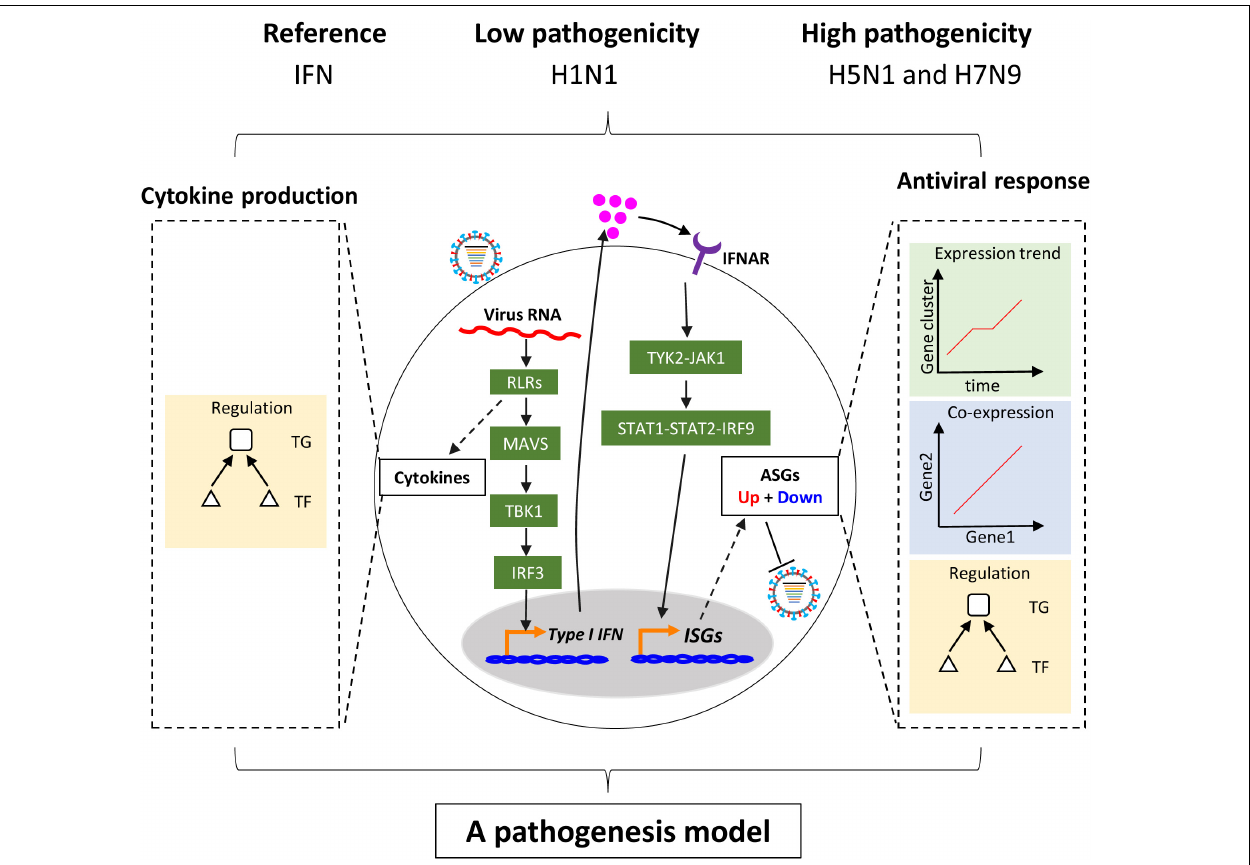
FIGURE 1 | Schema of study. Upon infection of influenza virus, viral RNAs are rapidly recognized by the RIG-I-like receptor (RLR) of host cells. On the one hand, RLR-dependent pathway induces secretion of type I interferons. The type I interferons bind to their receptors and activate the canonical Jak-Stat pathway, which further induces the expression of hundreds of interferon-stimulated genes (ISGs). The ISGs enable host cells to establish antiviral state with thousands of upregulated or downregulated host cellular antiviral state genes (ASGs). On the other hand, Recognition of virus triggers production of multiple cytokines including type I interferons through complex pathways. In this study, regulation of cellular antiviral responses and cytokines production was comprehensively compared between low and highly pathogenic